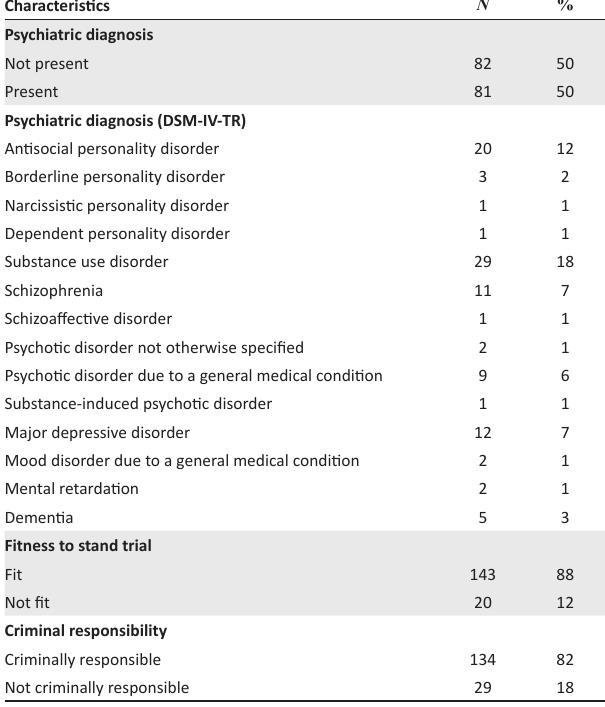
TABLE 3: Psychiatric observation outcomes.